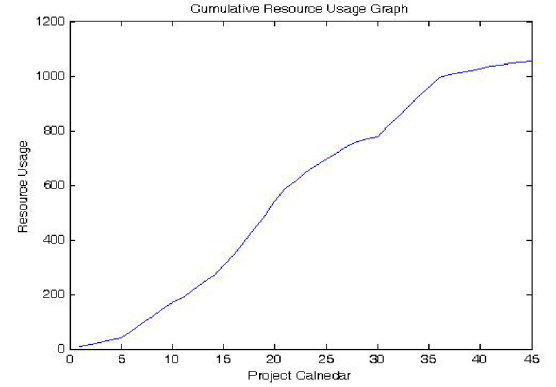
Figure 28. Cumulative resource usage for resource 2 of experiment 2 (after using forward method)